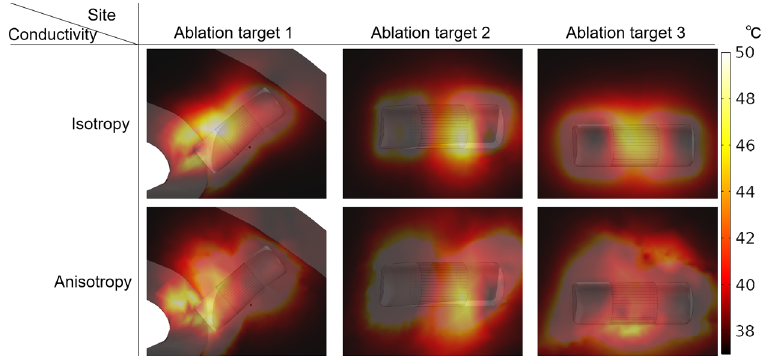
Figure 18. Under the condition of the same PFA parameters (see “Boundary Conditions”) and AC and the corresponding IC from the fourth electrical conductivity group with the highest anisotropy ratio, the final temperature distribution is generated in the myocardium at three ablation targets.